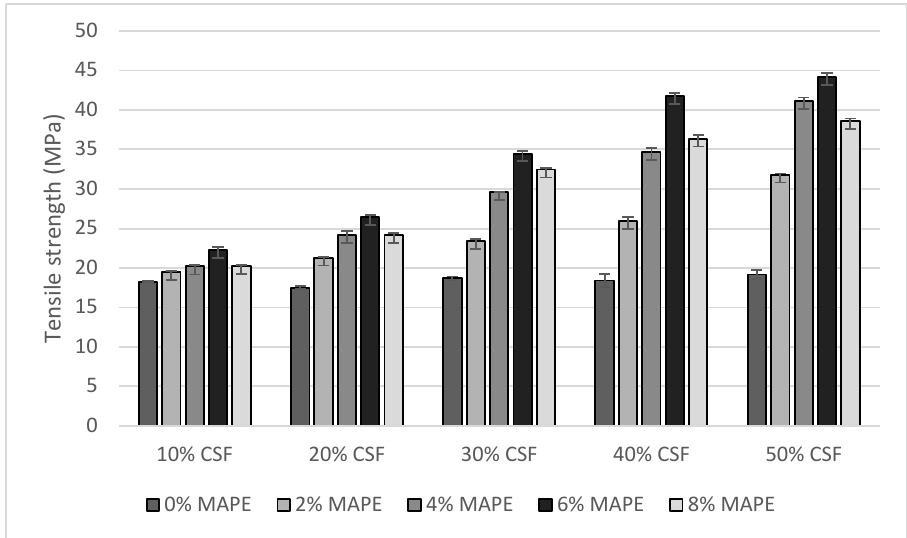
Figure 3. Evolution of the tensile strength of the composites against MAPE and CSF contents.